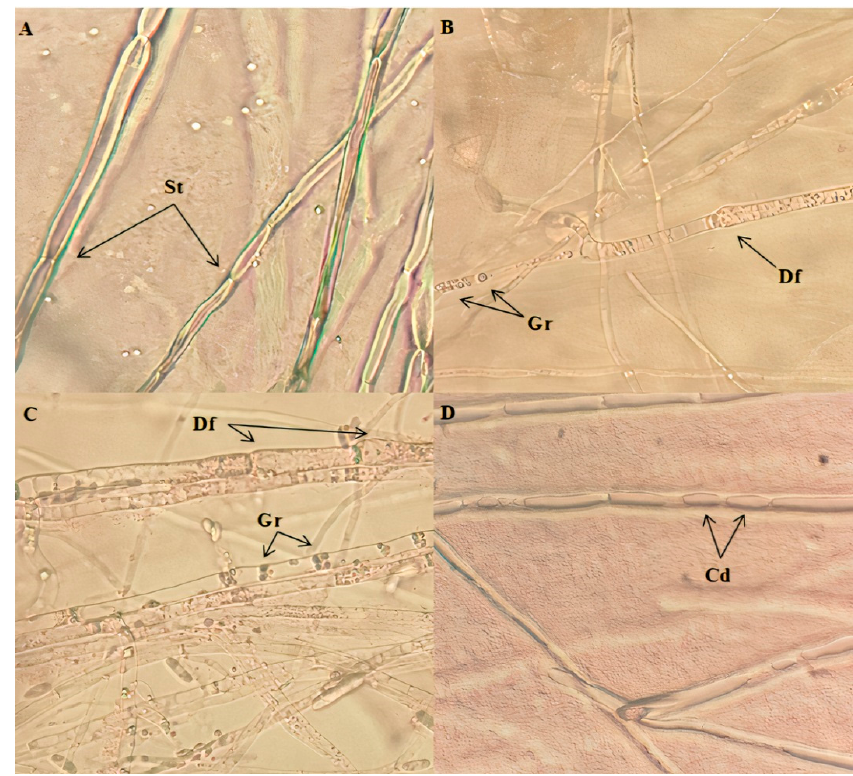
Figure 2. Light microscopy observations of the impact of selected Pseudomonas strains on Foc-S2 hyphae morphology (40×). ( A ) Control; ( B ) Effect of E1FP13; ( C ) Effect of E1PP6; ( D ) Effect of E1PP15. (St) Septa; (Gr) Granulations; (Df) Deformations; (Cd) Condensations .